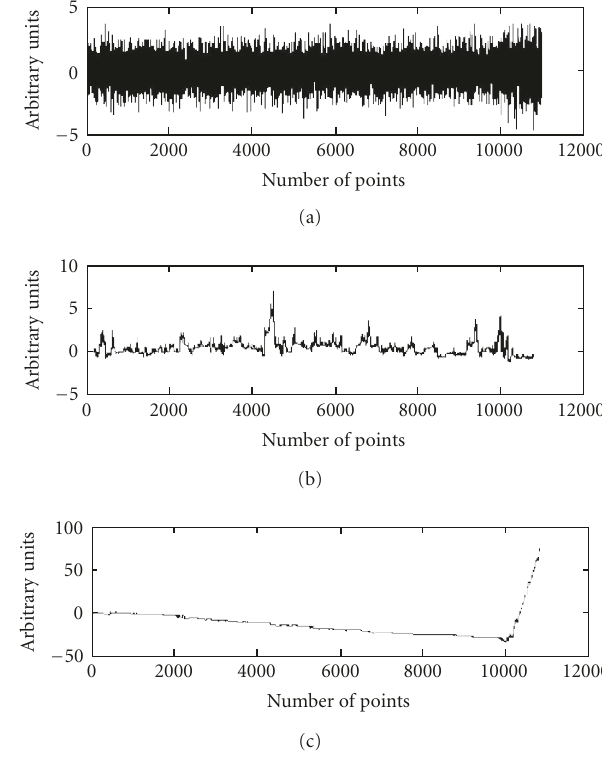
Figure 4: (a) Simulated signal containing a change in variance (from 1 to 2) at point 10000. (b) Evolution of DCS before and af- ter the change time (change not detected). (c) Evolution of MDCS before and after the change time (change detected). For all tracings, x -axis: number of points, y -axis: arbitrary